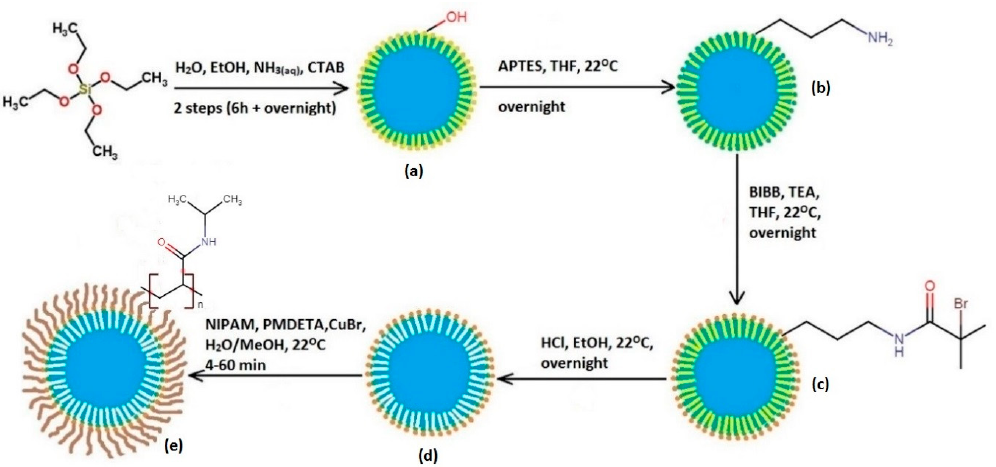
Figure 1. Scheme of the experimental route to obtain solid cores and mesoporous shells (SCMS)- poly(N-isopropylacrylamide) (PNIPAM). Synthesis of: ( a ) SCMS, ( b ) SCMS-APTES, ( c ) SCMS- α - bromoisobutyryl bromide (BIBB), ( d ) SCMS-BIBB(EX), ( e )